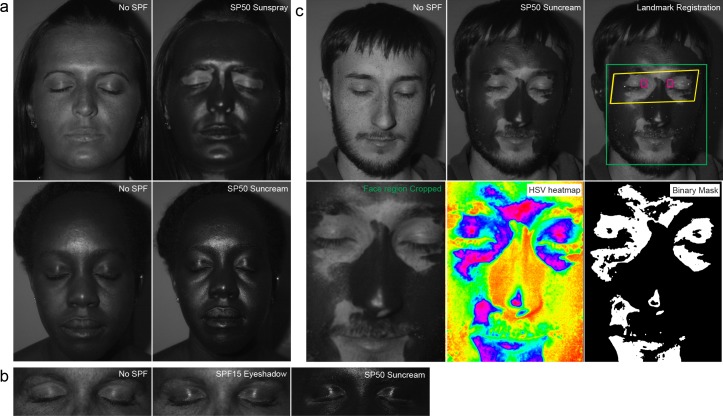
UV imaging as a mechanism to identify regions of incomplete sunscreen application.a) UV images before and after sunscreen application. b) UV images of eyelid region showing the impact of SPF15 makeup compared with SPF50 sun cream. c) UV images analysis steps; top left and middle panels, before and after images from sunscreen application. Top right panel, facial landmarks identified by dlib package: green box; cropped facial region, yellow box; eyelid region, magenta boxes; medial canthal areas. Bottom left, cropped facial region. Bottom middle, hue saturation value (HSV) heat map produced from grayscale image, bottom right binary mask generated from thresholding the HSV heat map.